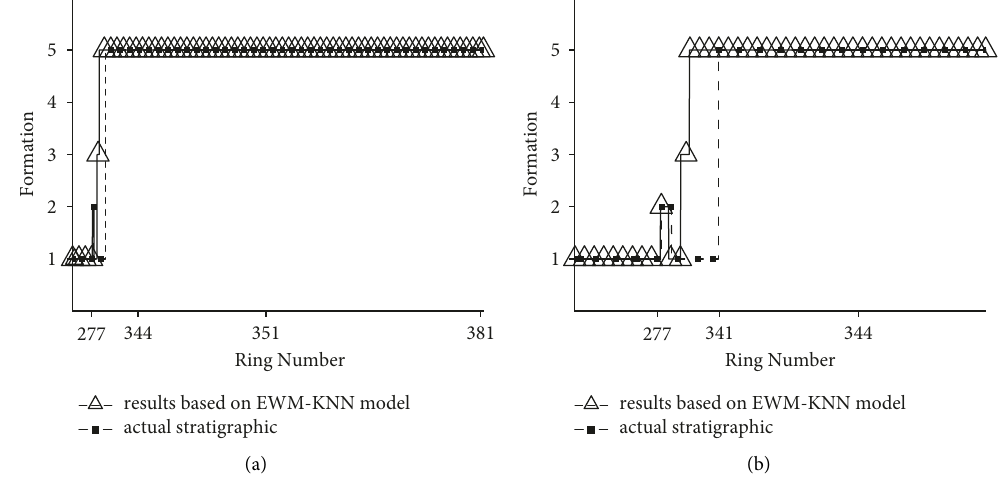
Figure 10: Formation recognition results based on the EWM-KNN model and actual stratigraphic correlation map. (a) Formation identification results of EWM-KNN model to test set. (b) Partially enlarged